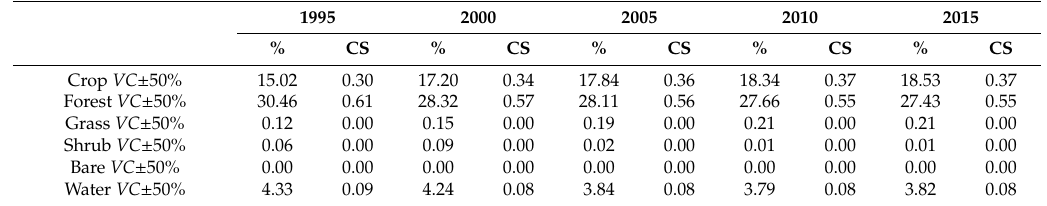
Table 7. Coe ffi cient of sensitivity of the ecosystem service values of Jiangxi